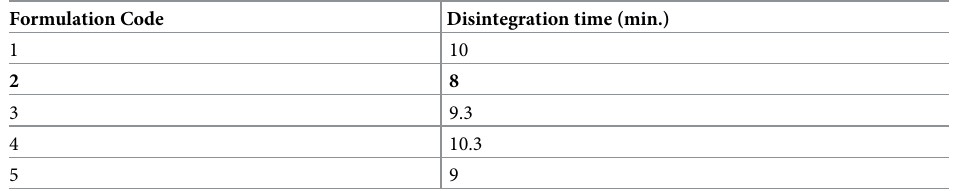
Table 6. Results after the disintegration test of the capsules in Phosphate Buffer Solution (PBS), pH 6.8.